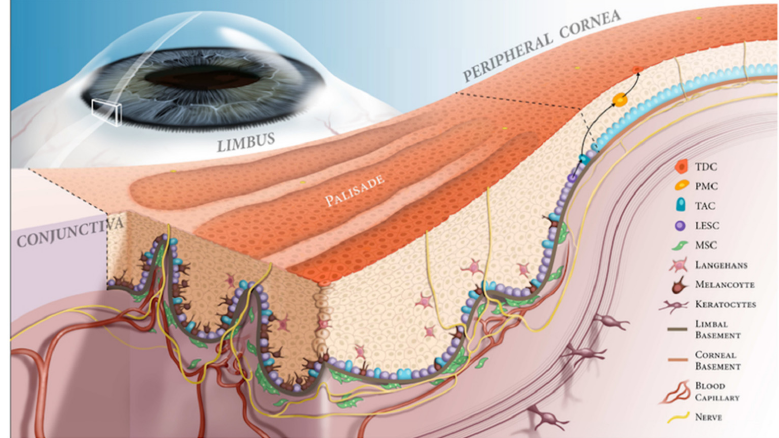
Figure 1. Limbal niche. Illustration of the limbal niche, focusing on the palisade of Vogt. The palisades of Vogt form crypts in the limbal epithelium, allowing for close contact between LESCs and supportive cells, including melanocytes, keratocytes, mesenchymal stem cells and Langerhans cells. These cells, along with the basement membrane and neurovasculature, provide growth factors, nutrients and structural support to promote proper LESC proliferation and differentiation. At the border of the limbal and corneal basement membranes, LESCs divide into progenitor cells or transient amplifying cells (TAC). The TACs divide into postmitotic cells (PMCs) and migrate centrally. These PMCs differentiate into terminally differentiated epithelial cells (TDCs) to replace lost cells on the corneal surface. Use of illustration permitted by [5].